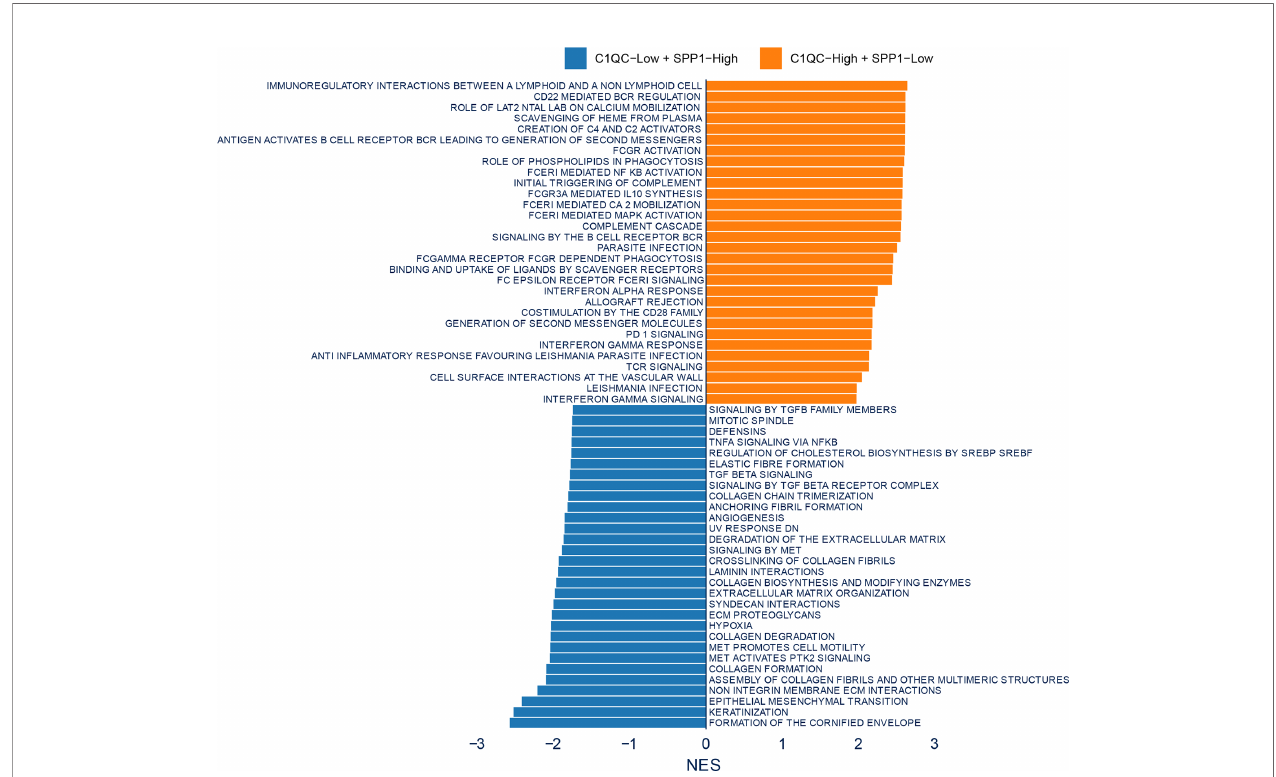
FIGURE 4 | Enrichment plots from gene set enrichment analysis (GSEA). Differential pathway enriched in C1QC low + SPP1 high TAMs gene signatures group and C1QC high + SPP1 low TAMs gene signatures